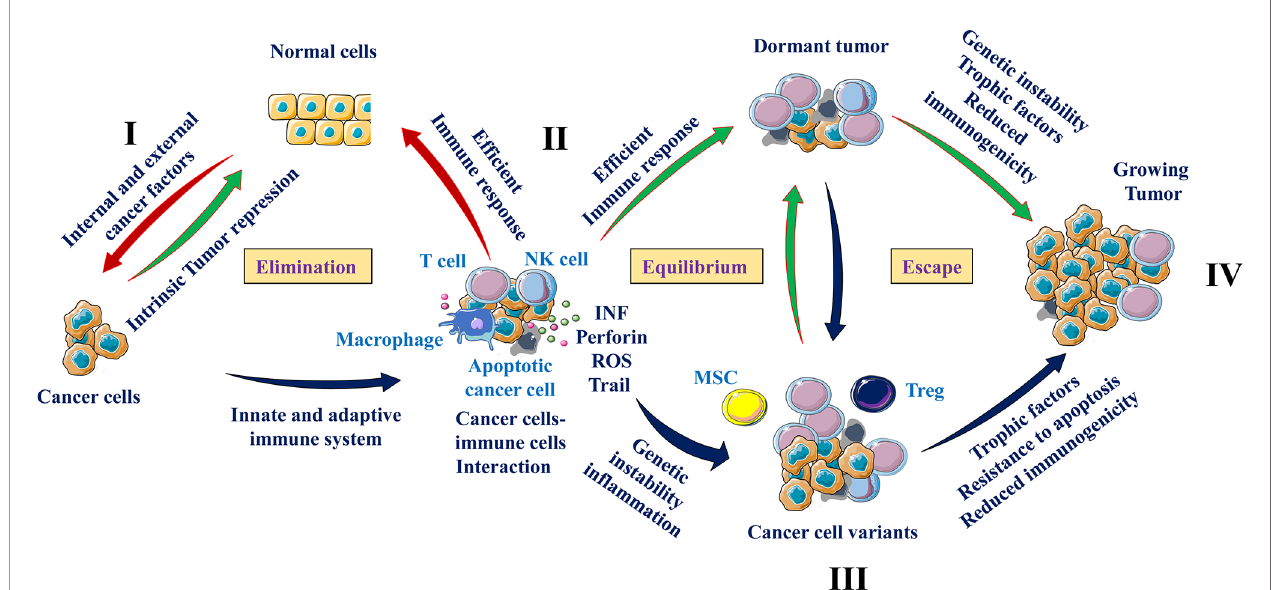
FIGURE 2 | Cancer cells and immune cells communication. From immune surveillance to immune escape. Exposure to internal and/or external risk factors induced cell transformation (I) of which the development is repressed by intrinsic tumor suppressing mechanisms (e. g. tumor suppressor genes and apoptosis) (II). During the elimination phase, immune cells such as natural killer cells (NK), and T cells are able to recognize (e.g. through presence of NKG2D ligand) and eliminate tumor cells. The equilibrium phase involves the continuous elimination of tumor cells by immune cells secreting cytotoxic agents (INF, perforin and others) and the accumulation of resistant cancer cell variants (III). At the escape phase, as a result of heterogeneity, tumor cells that are less immunogenic are able to escape immunosurveillance and secrete cytokines and chemokines that recruit immunosuppressive cells (Tregs, MSCs and MDSCs), which suppress the antitumor immune responses through different pathways including T cell and NK cell activity repression